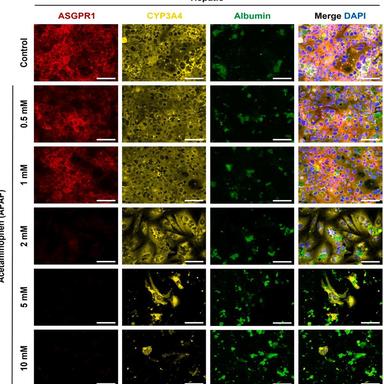
Morphological analysis of hepatic cell layers in the Dynamic42 3D model. Representative immunofluorescence images of upcyte® hepatocytes (donor 732–03) stained for ASGPR1 (red), CYP3A4 (yellow), albumin (green), nuclei (DAPI, blue) after treatment with control (10% PBS) or 0.5, 1, 2, 5 and 10 mM APAP for 7 days. Bar - 100 µm.